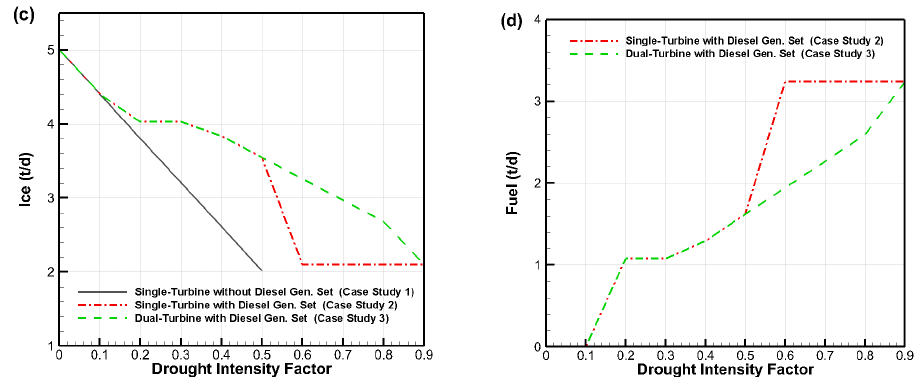
Figure 11. The optimal polygeneration product output of the polygeneration such as the ( a ) electricity, ( b ) water, and ( c ) ice, and the raw material such as the ( d ) diesel fuel.